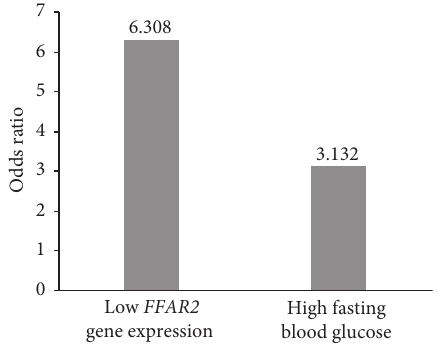
Figure 3: Independent risk factors for AMI. AMI � acute myo- cardial